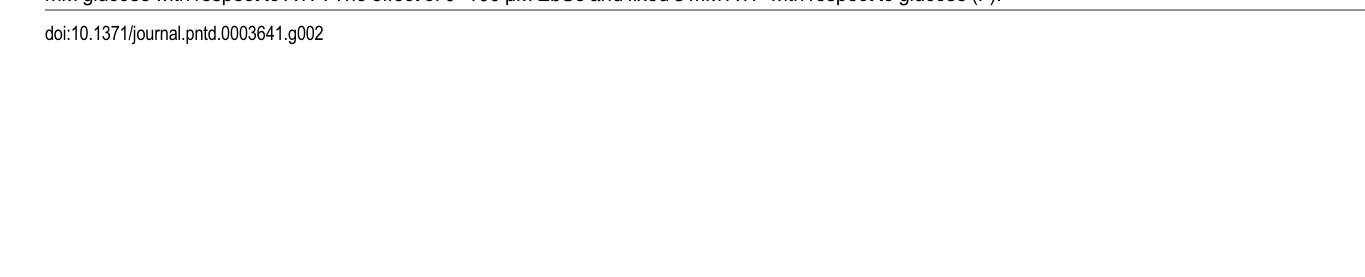
PLOS Neglected Tropical Diseases | DOI:10.1371/journal.pntd.0003641 March 23,